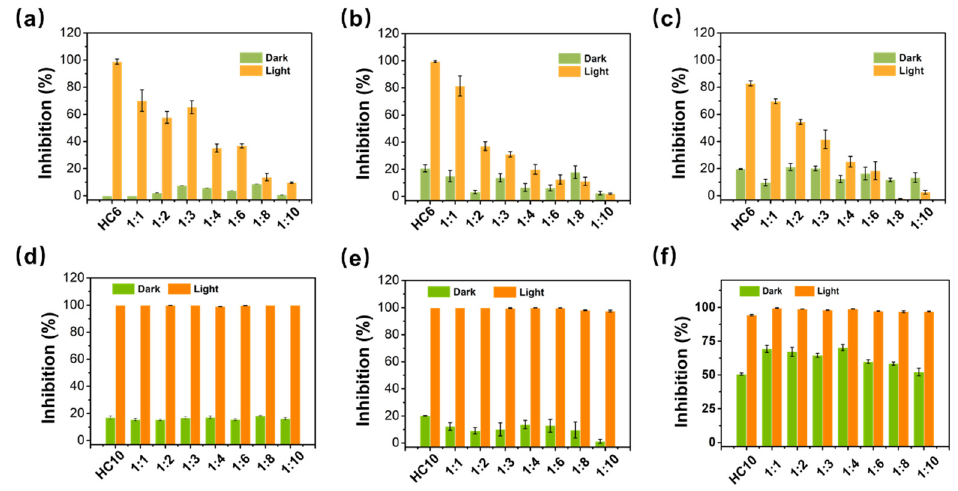
Figure 4. Inhibition efficiency of HC6 and its supramolecular assemblies on the growth of ( a ) E. coli , ( b ) S. aureus , ( c ) C. albicans . Inhibition efficiency of HC10 and its supramolecular assemblies against ( d ) E. coli , ( e ) S. aureus , ( f ) C. albicans . [HC6/HC10] = 25 μ M, [CB[7]] = 0, 25, 50, 75, 100, 150, 200, 250 μ M, the white light is 65 mW/cm 2 , the irradiation time is 10 min.